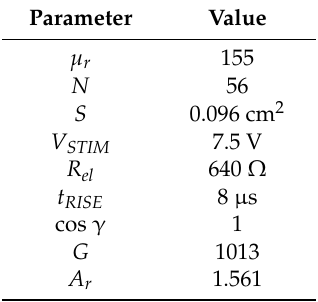
Table 1. Values used for the model parameters in the experimental validation.